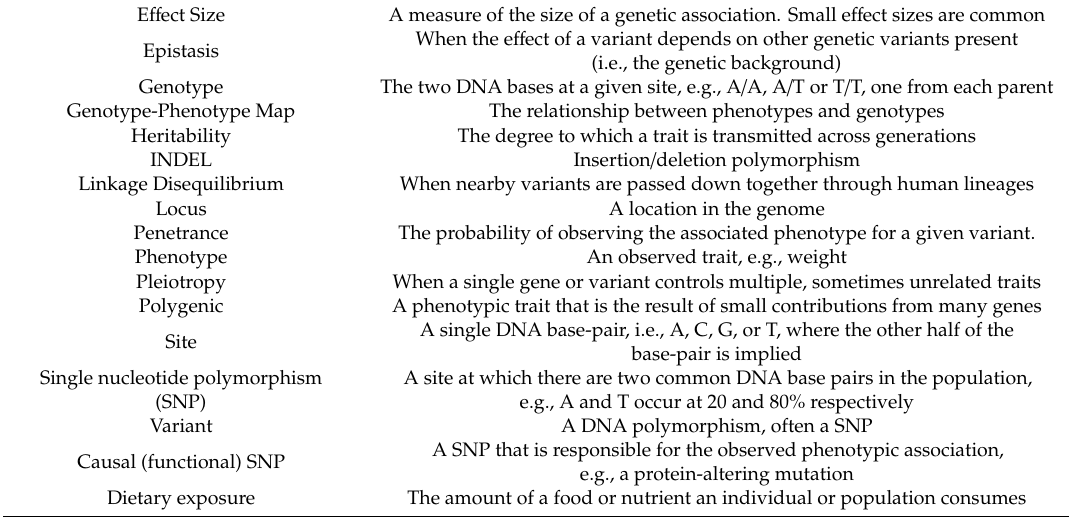
Figure 1. Basic architecture of a gene showing exons (eventually become the mature mRNA transcript), introns (removed during transcription), coding sequence regions within exons (CDS), and untranslated portions of exons (UTR). Table 1. Glossary of common genetic terms.